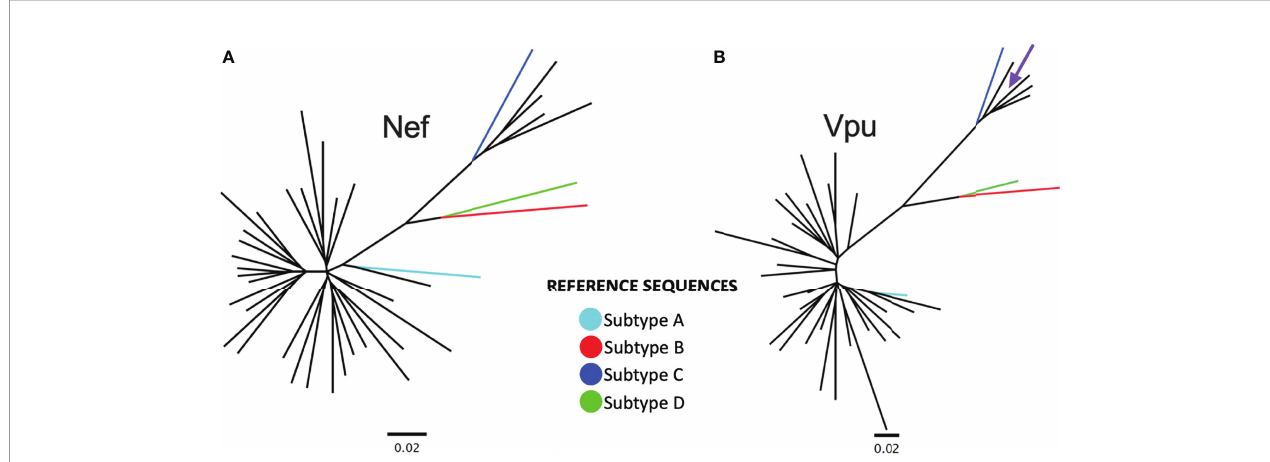
FIGURE 1 | Nef and Vpu phylogenies from the survivor cohort. (A) Unrooted phylogeny inferred from an alignment comprising 34 nef sequences from Rwandan long-term survivors (LTS) along with HIV-1 subtype A, B, C and D reference sequences. The scale, shown below the phylogeny, is measured in estimated nucleotide substitutions per site. (B) A corresponding phylogeny for 34 vpu sequences. The arrow points to a vpu sequence with a branch length too short to see.